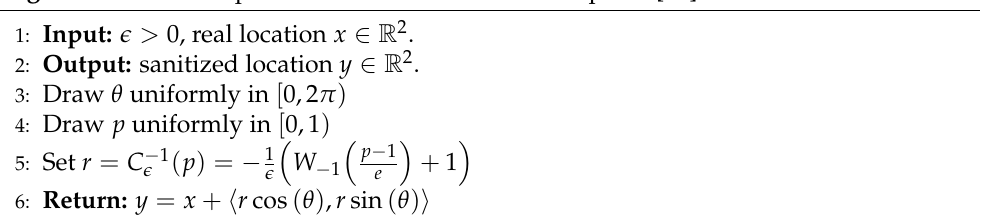
Algorithm 1 Polar Laplace mechanism in continuous plane